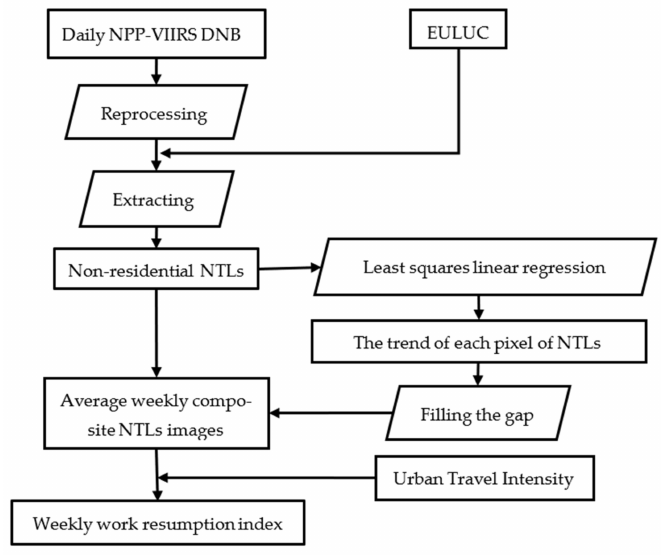
Figure 3. The flowchart of calculating the work resumption index.